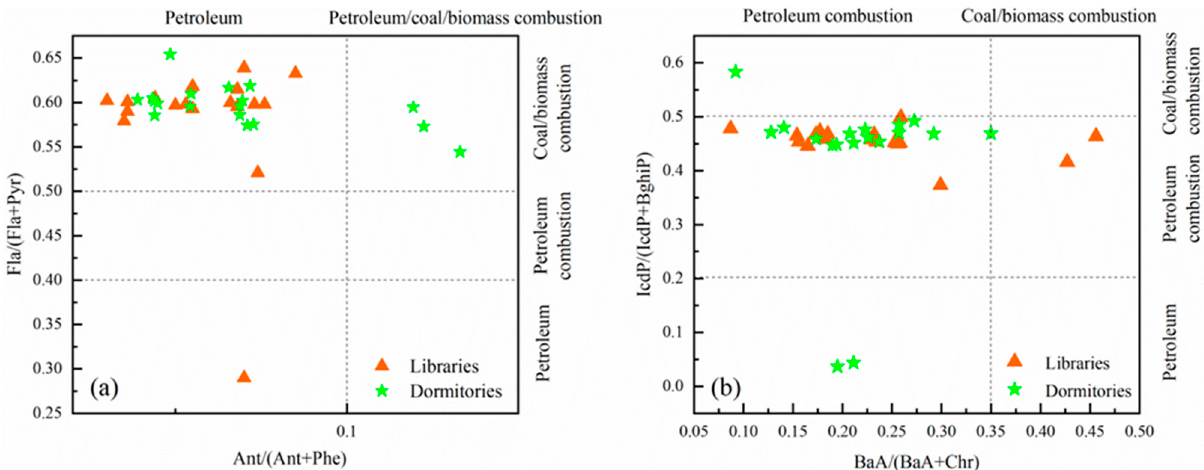
Figure 3. Scatter plot of diagnostic ratios: ( a ) Ant/(Ant+Phe) vs. Fla/(Fla+Pyr); ( b ) BaA/(BaA+Chr) vs. IcdP/(IcdP+BghiP). Table 2. Source identification of PAHs in dustfall by